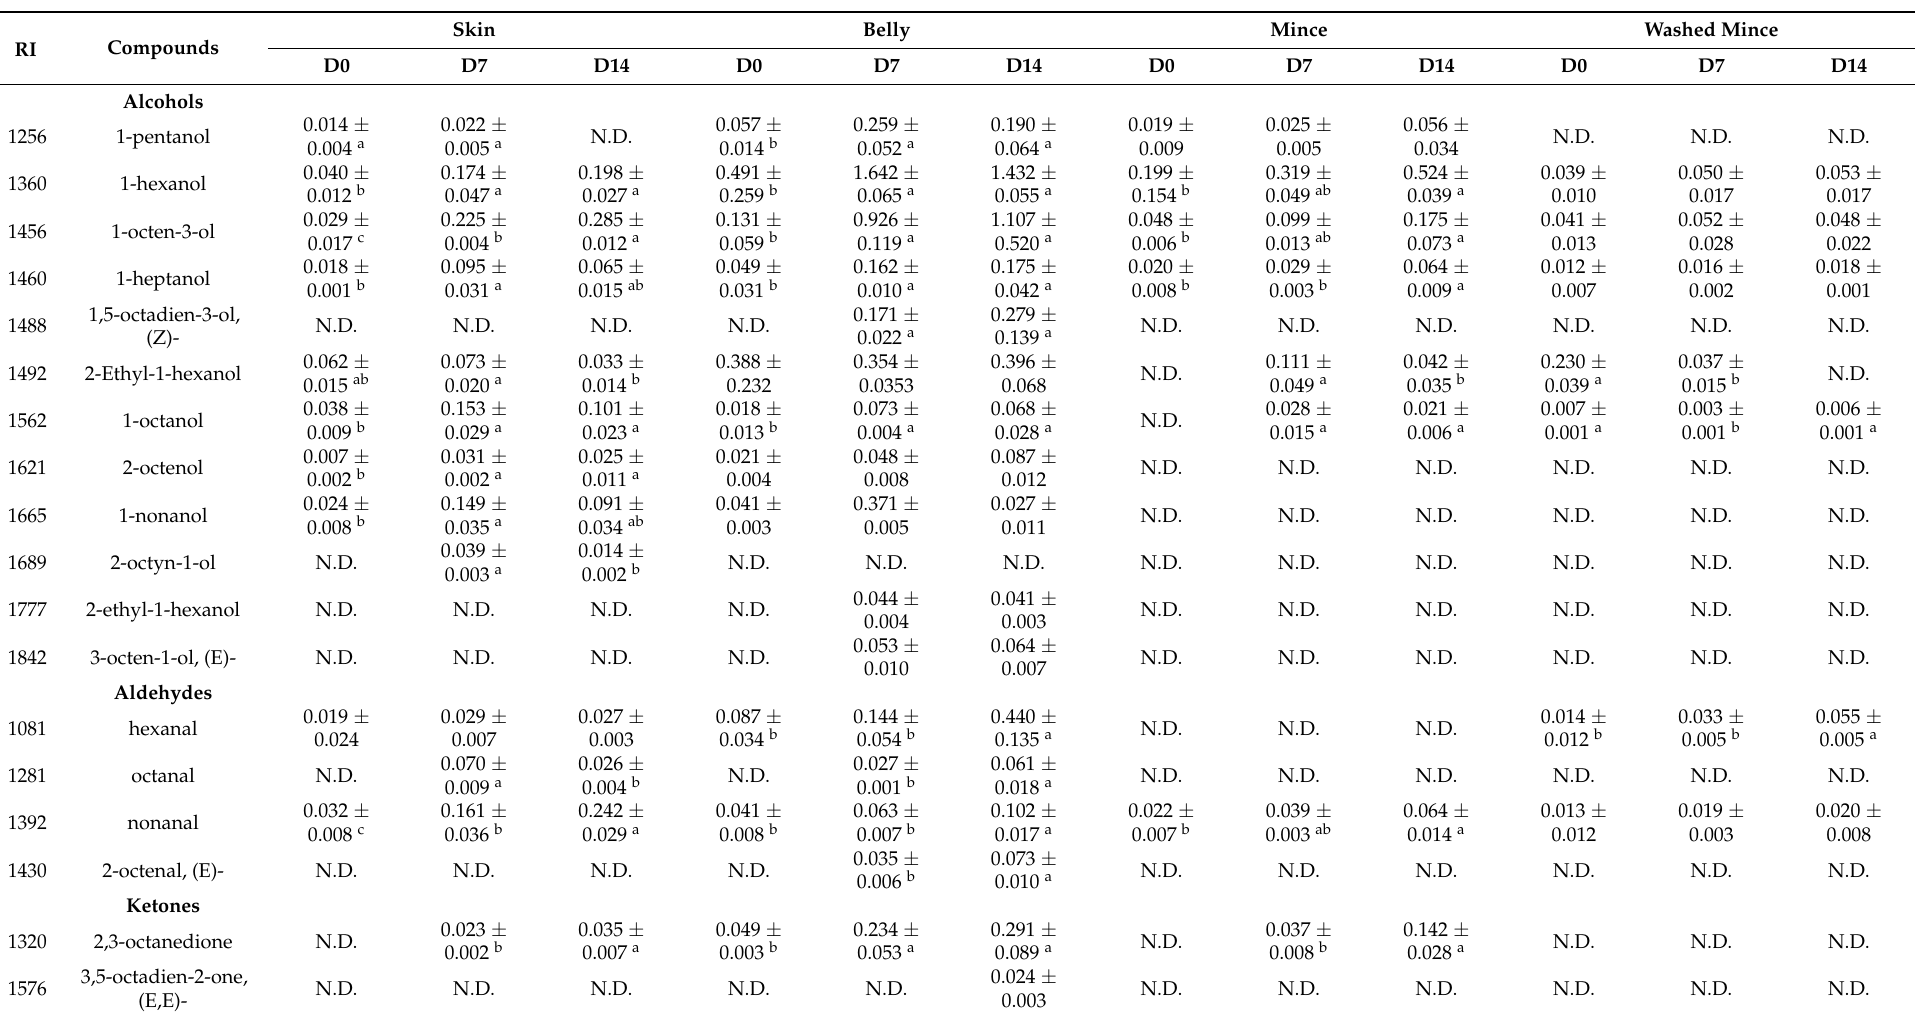
Table 3. Relative signal intensities of volatile compounds of various part tissue of silver carp during ice storage and their respective washed mince. RI